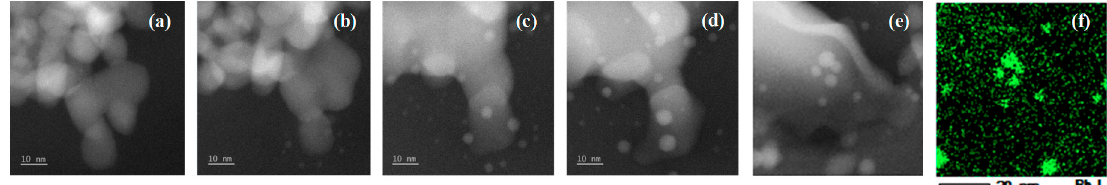
Figure 6. In situ TEM and EDS images of Rh/ZrO 2 at ( a ) 300 °C in N 2 , ( b ) 900 °C in N 2 , ( c ) 950 °C in N 2 , and ( d ) 950 °C in 1% O 2 (balance N 2 ); ( e ) TEM data at 300 °C after cooling from 1000 °C. ( f ) EDS measurement result after ( e ) at the same observation point.